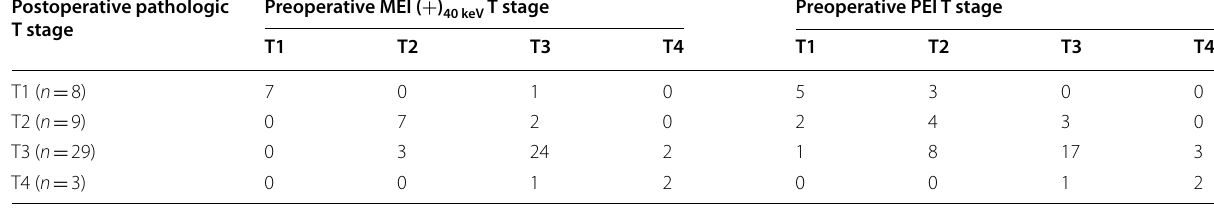
Table 4 MEI ( ) , PEI versus postoperative histopathology for T stage of esophageal cancer in the venous phase 40 keV +